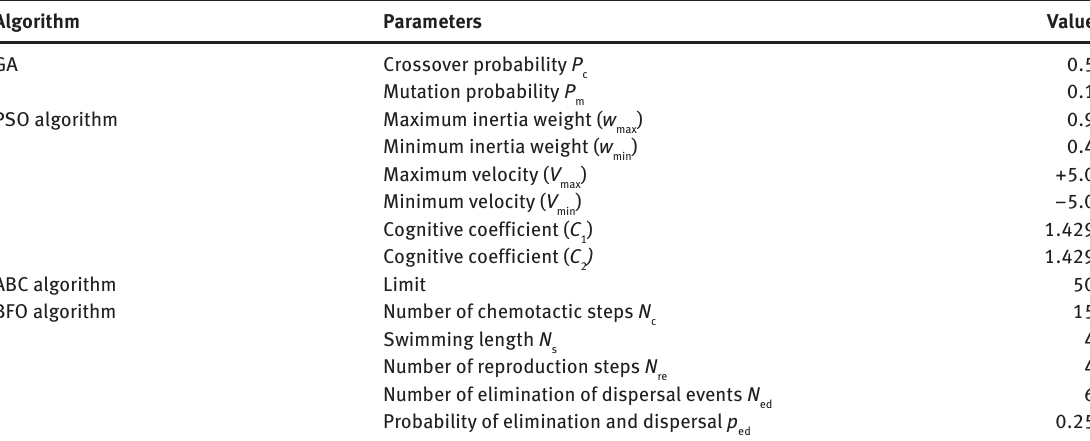
Table 1: Parameter Settings for the GA, PSO, and ABC